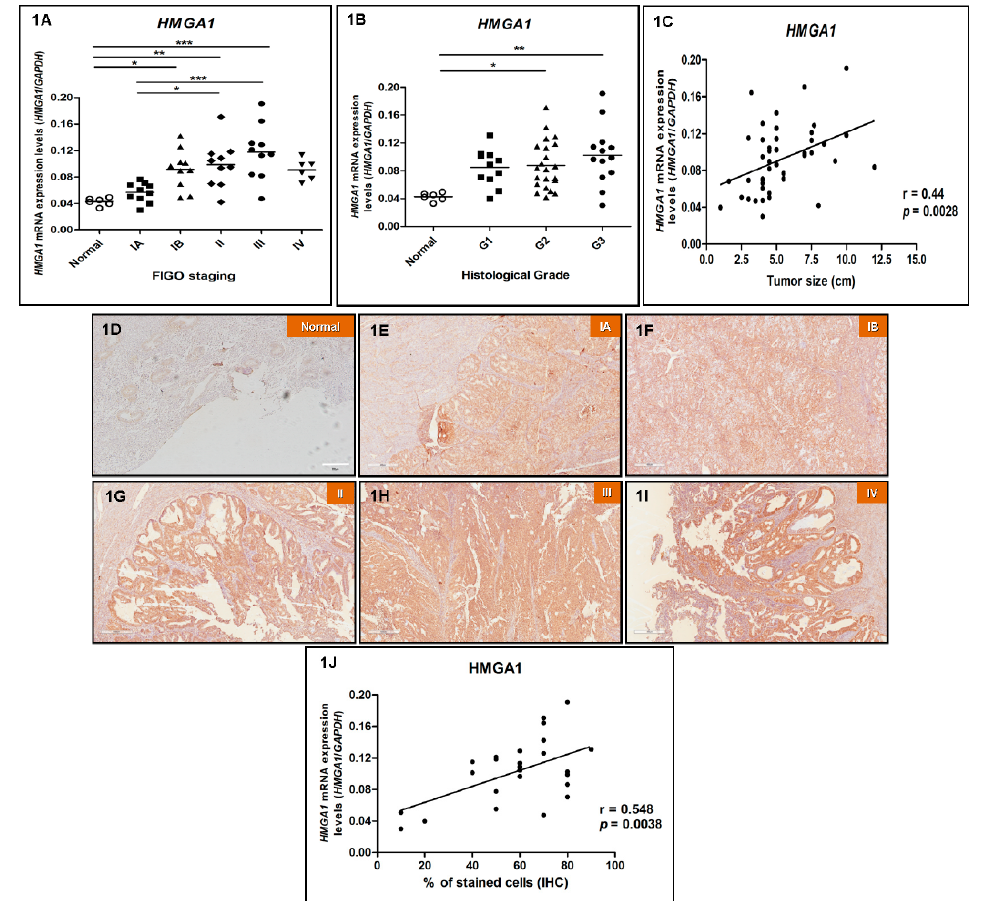
Figure 1. High-mobility group A protein 1 (HMGA1) mRNA and protein expression pattern in endometrioid endometrial adenocarcinomas (EEC). HMGA1 gene and protein expression analysis